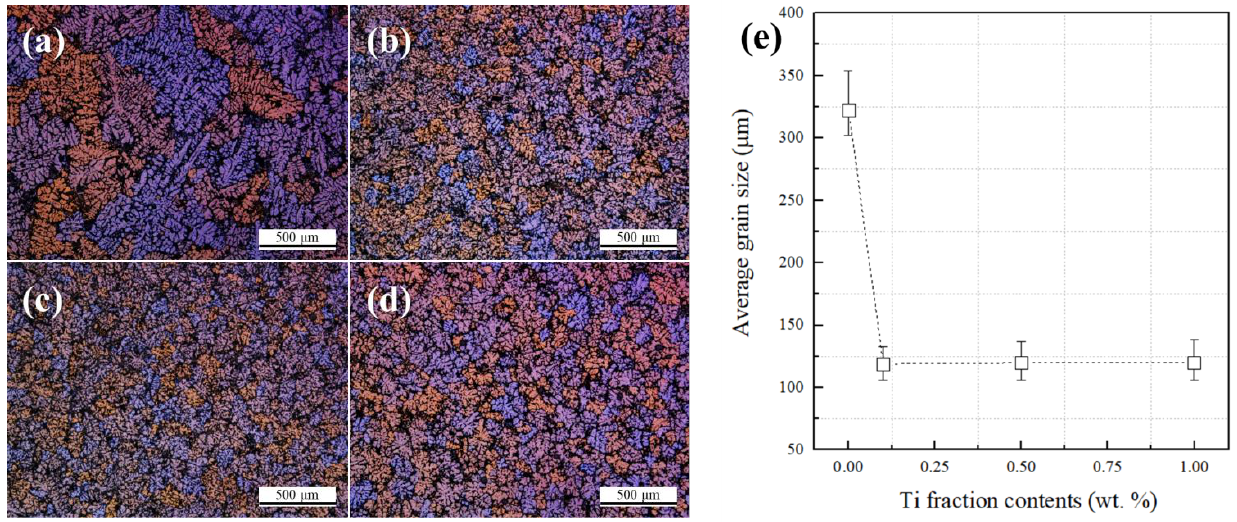
Figure 3. Polarized microscope images of the Al–8Zn–6Si–4Mg–2Cu alloy with different amounts of Ti: ( a ) without Ti; ( b ) at 0.1% of Ti; ( c ) at 0.5% of Ti; ( d ) at 1% of Ti; and ( e ) the relationship between average grain size and Ti content.